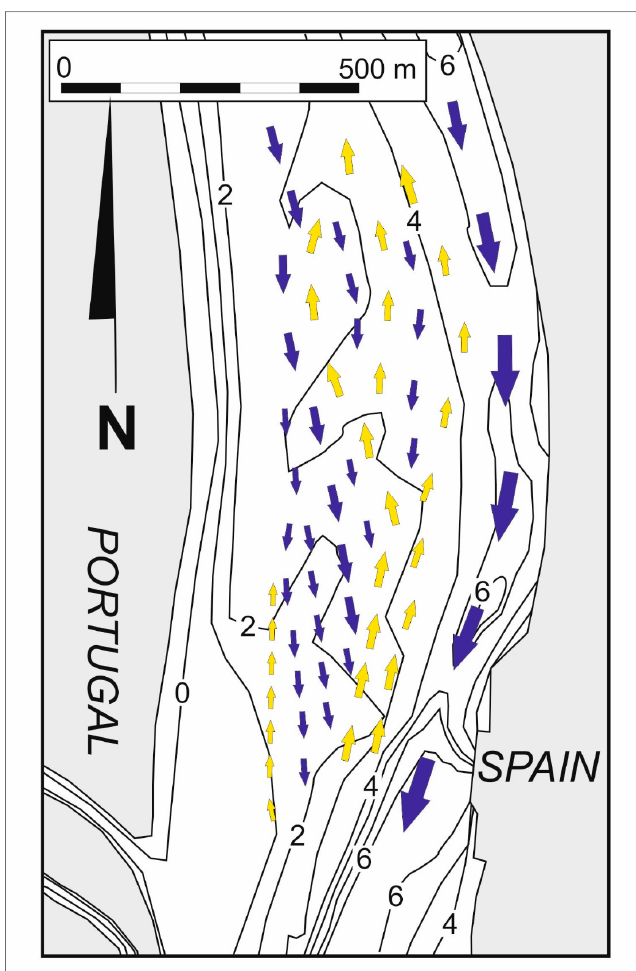
Figure 10. Main patterns of sand transportation in the outer area according to the sense of the dune’s crests. Yellow (clear) arrows indicate the trajectories of the flood transport and blue (dark) arrows indicate the trajectories of the ebb transport. The size of the arrows is indicative of the intensity of the transport according to the dune size. Values for the potential bedload transport have been estimated using the near bottom current velocities and grain size parameters in two sections of the estuary during both neap and spring tidal conditions. In a general way, it can be affirmed that the capacities of the sediment transport of the ebb currents are higher than the flood ones under every tidal condition. Thus, the net transport balance occurs during the ebb. The values of the net potential transport balance are much higher in the outer estuary than in the inner estuary, reaching over double during the neap tides and triple for